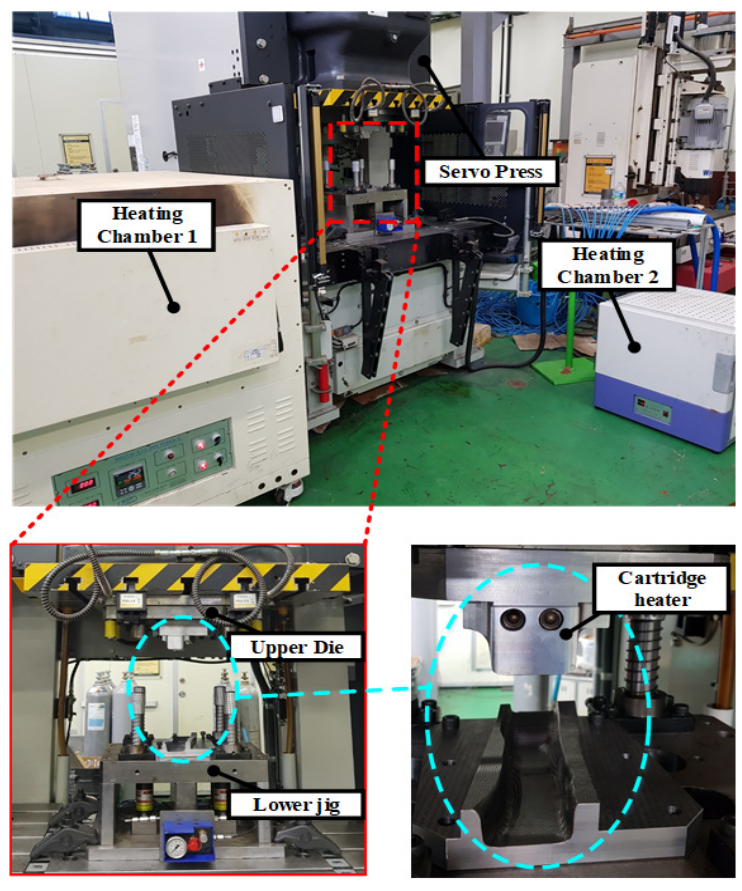
Figure 12. The experimental apparatus for the PCM process.